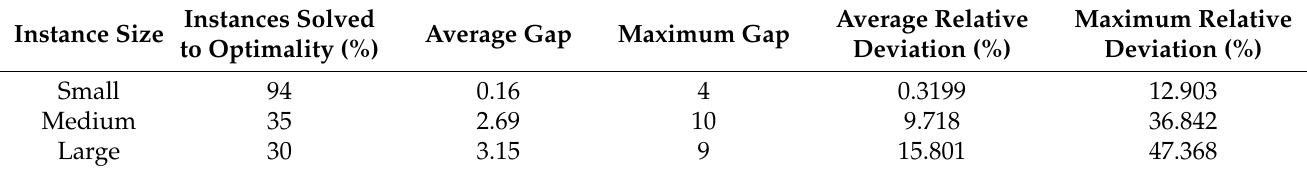
Table 8. Summary of the heuristic performance for generated